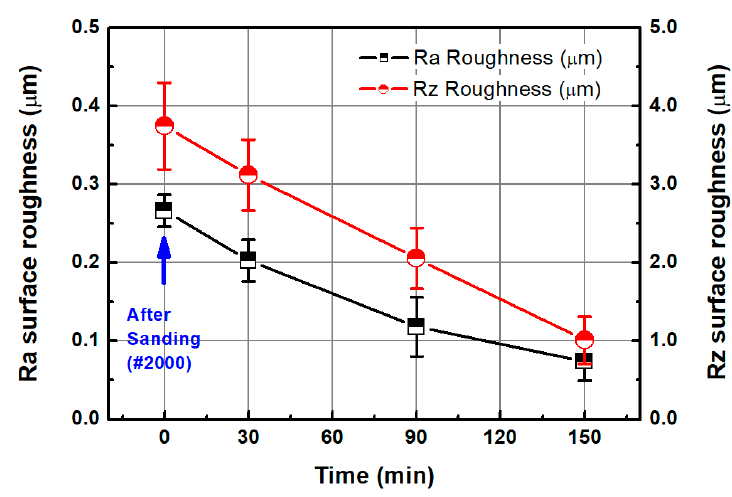
Figure 11. Sa and Sz values as functions of CMP processing time in two-step polishing method. Micromachines 2020 , 11 , x